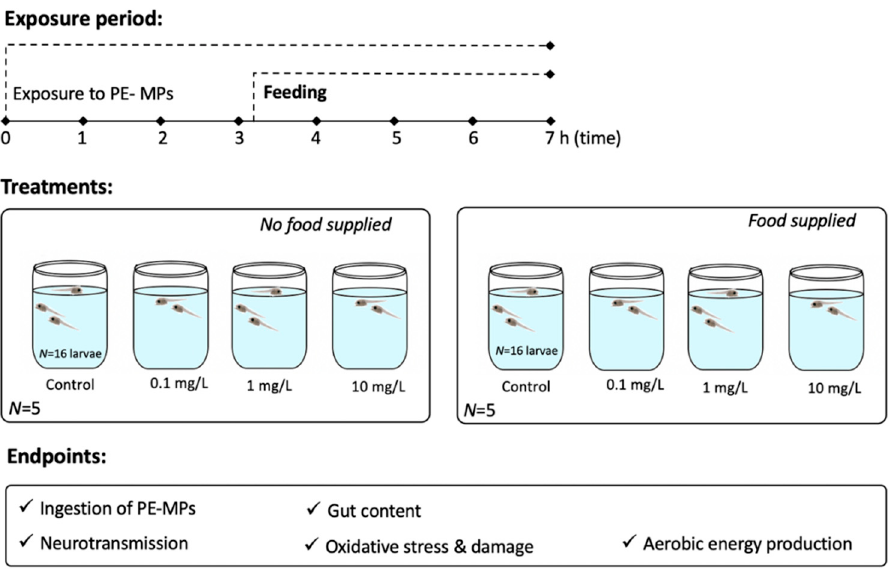
Figure 1. Schematic representation of the experimental setup and target endpoints.